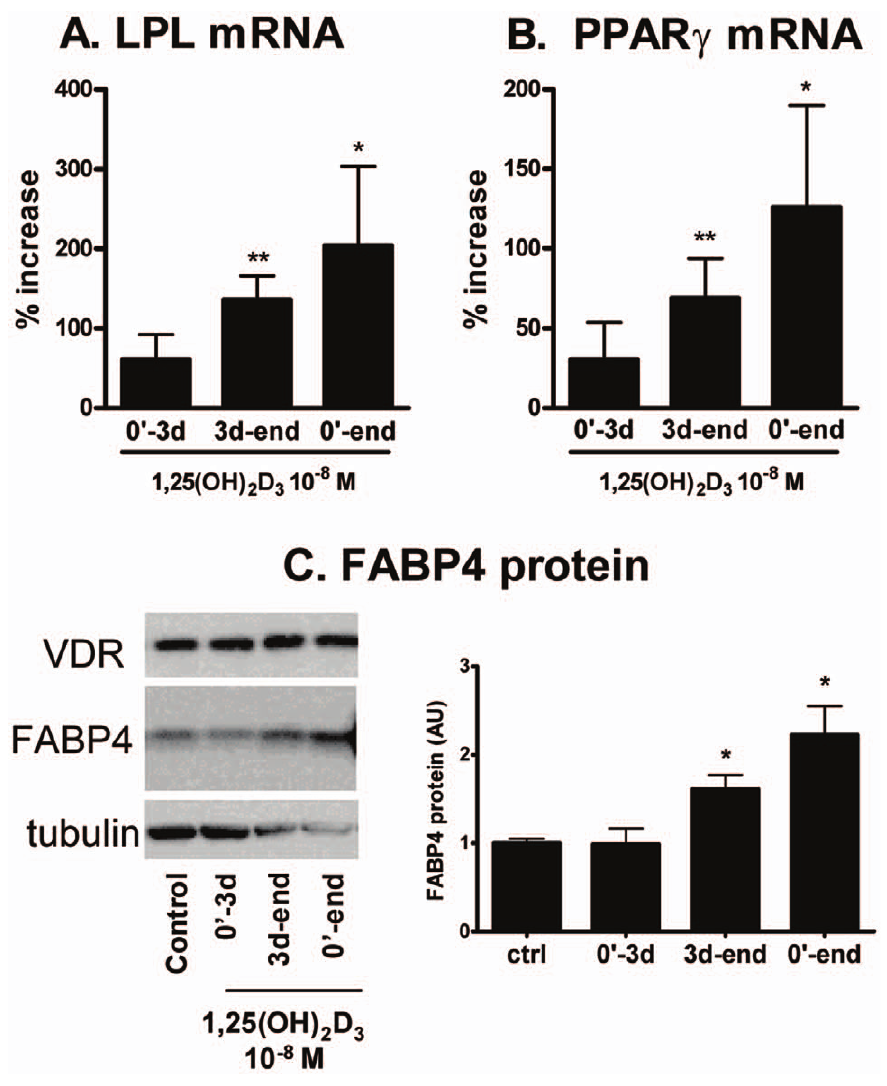
Figure 5. 1,25(OH) 2 D 3 promoted the maturation phase of adipogenesis. Human preadipocytes were differentiated in the adipogenic cocktail for 3 days and then maintained in the maintenance media until harvest (d13–14). 1,25(OH) 2 D 3 (10 2 8 M) was added during the first 3 days of induction (0 9 –3d), maturation (3d-end), or continuously throughout (0 9 -end). Expression levels of adipogenic markers [LPL (A, n=6) and PPAR c (B, n=6) mRNA and FABP4 protein (C, n=4)] were measured after differentiation. Data are presented as % increase over vehicle control. *, p , 0.05, **, p , 0.01, vehicle control vs. 1,25(OH) 2 D 3 treatment.